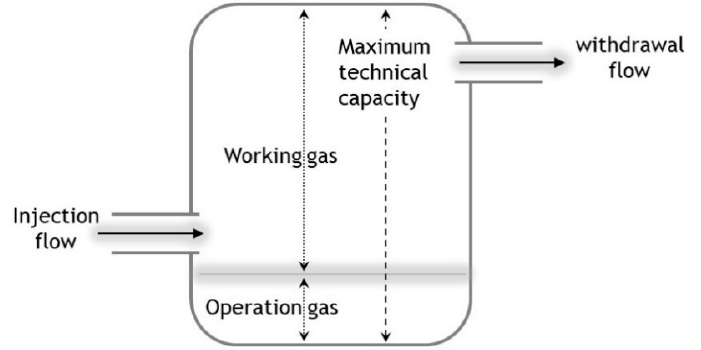
Figure 1. Gas storage unit schema.